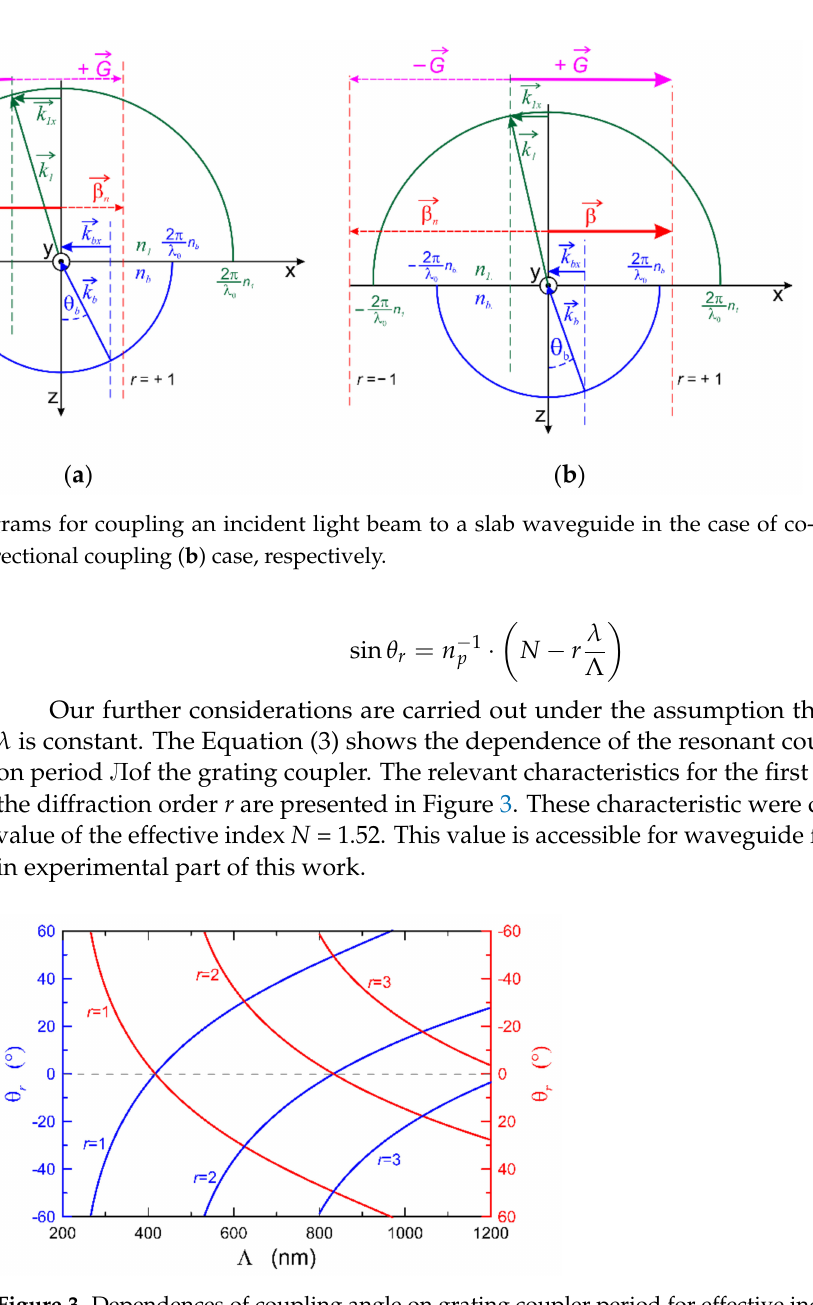
Figure 3. Dependences of coupling angle on grating coupler period for effective index N = 1.52 and wavelength λ = 632.8